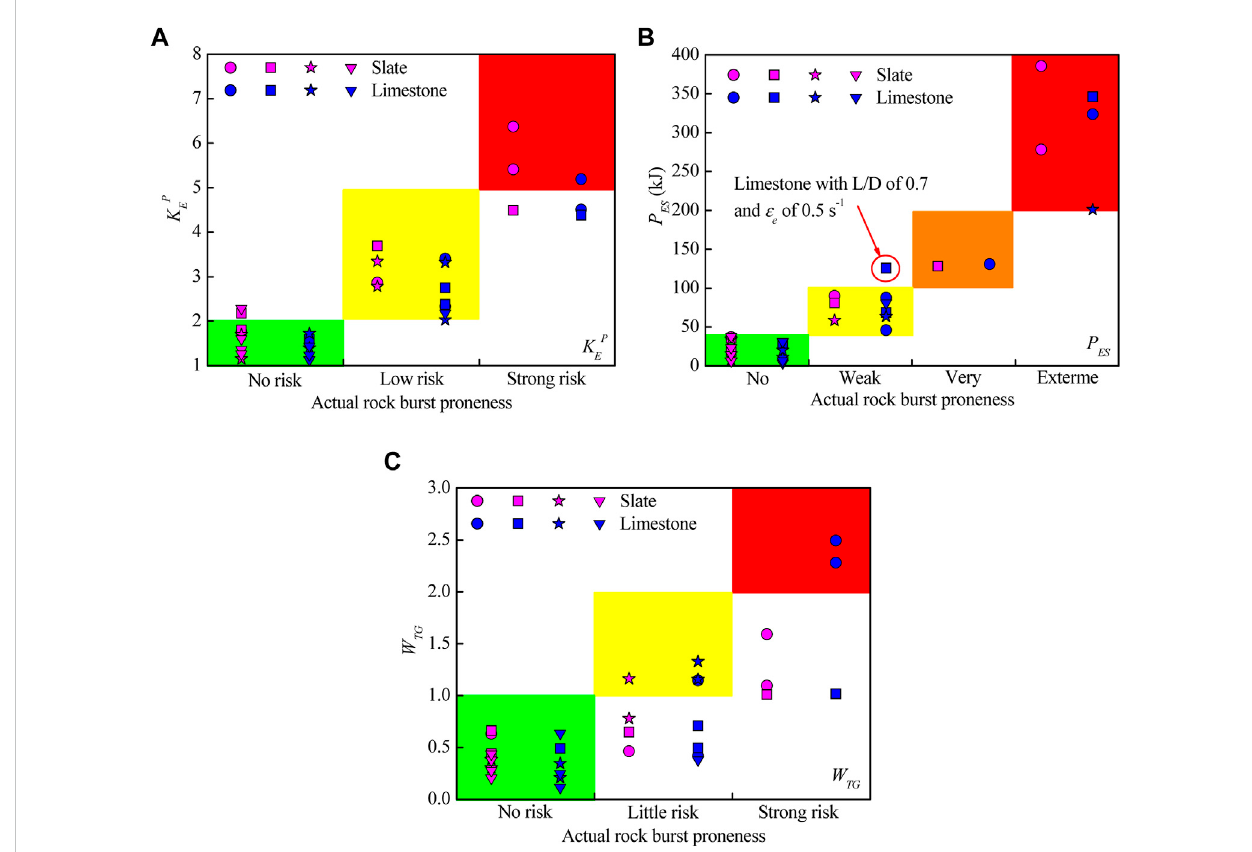
FIGURE 14 Relationship between the three indices, (A) K P E , (B) P ES , and (C) W TG , and actual rock burst proneness.